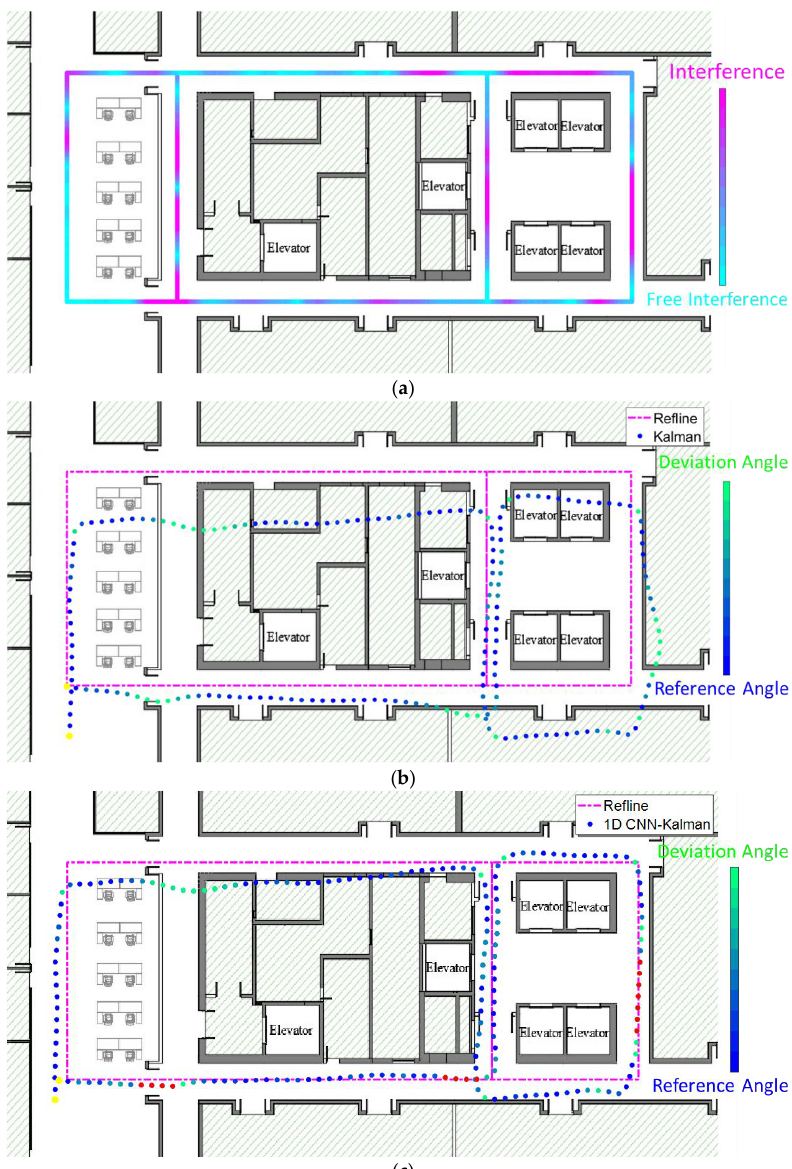
Figure 6. ( a ) The measurement of magnetic field in an indoor environment. ( b ) The distribution